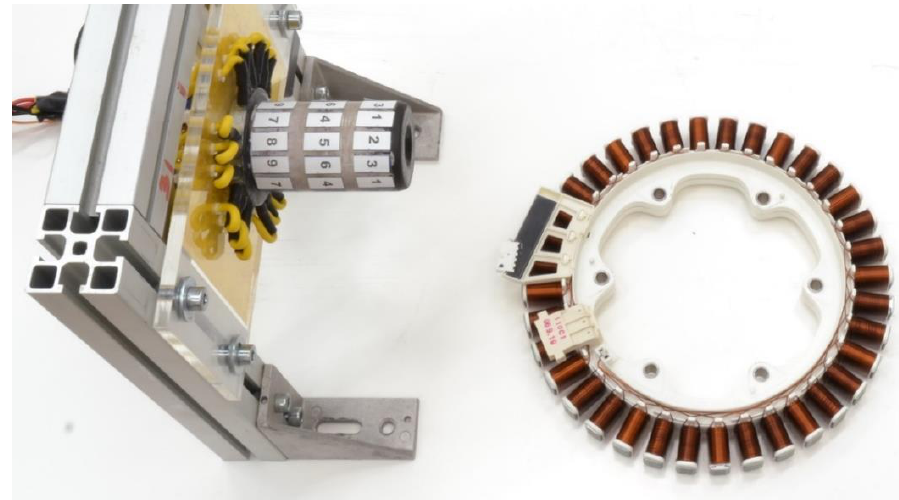
Figure 5. Comparison of 2 stators with a different structure, in terms of a different number of stator slots and a different diameter.